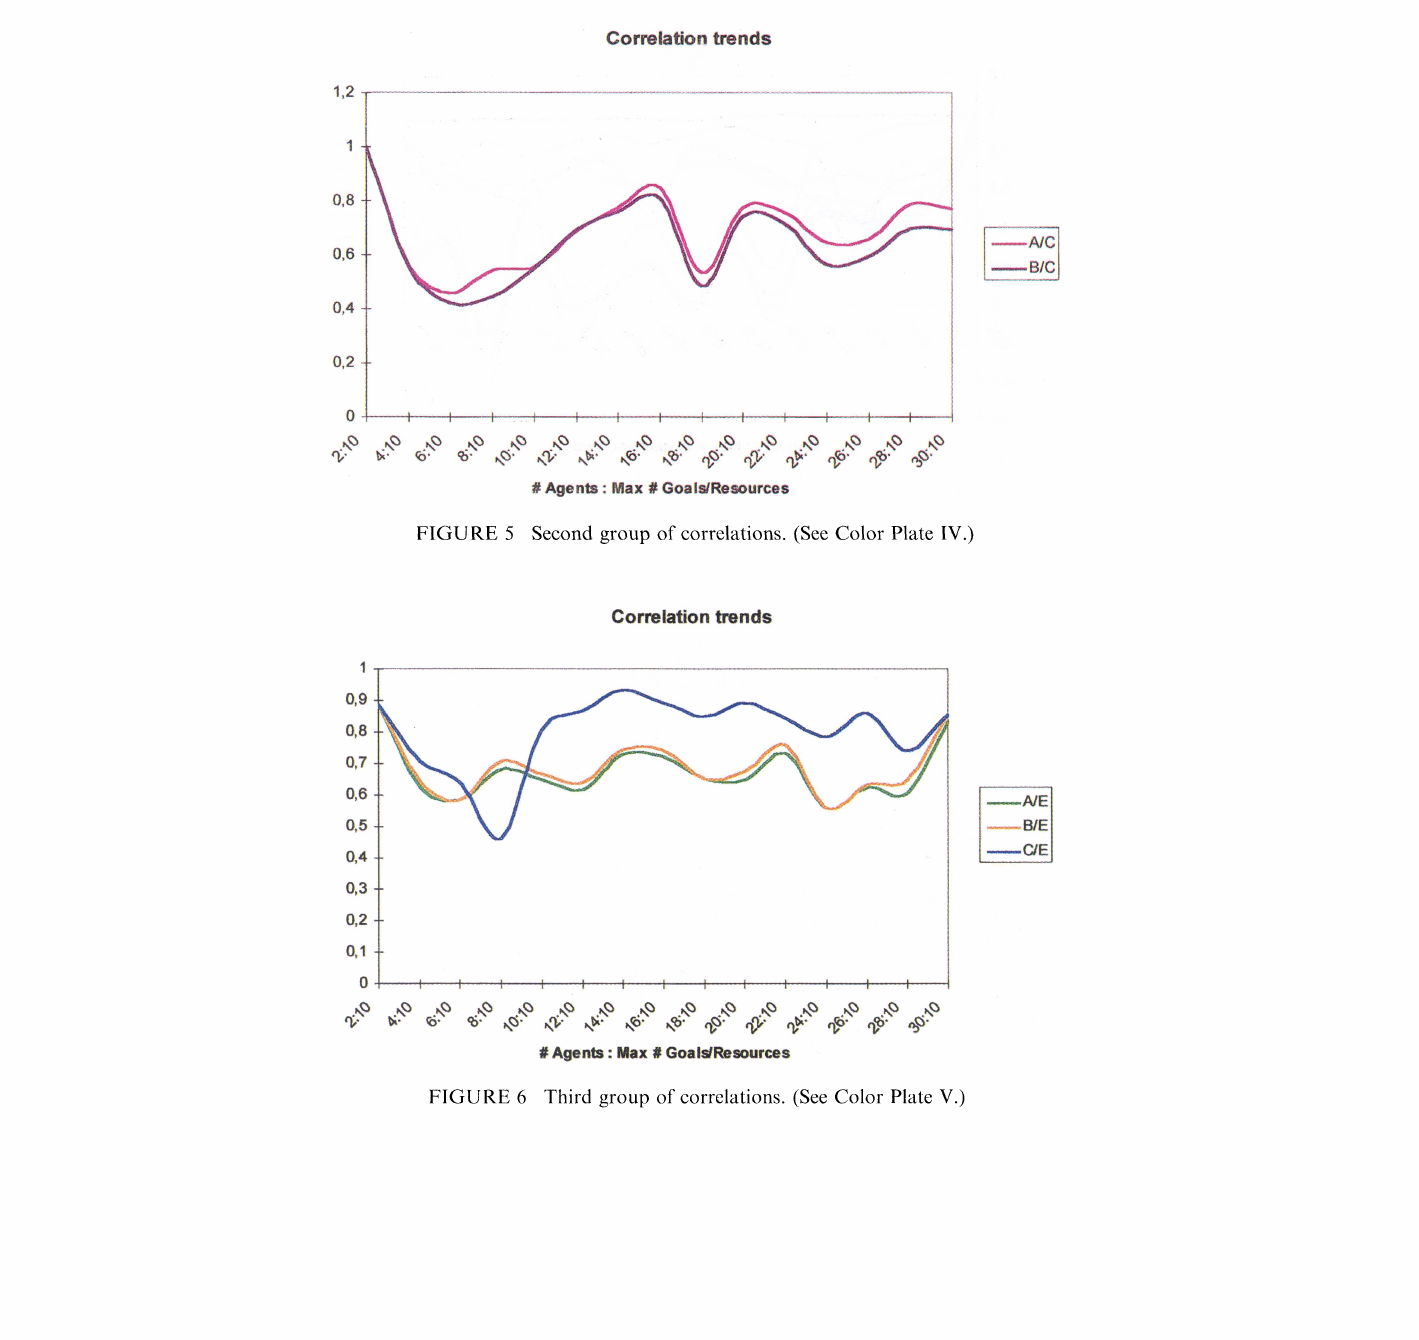
FIGURE 6 Third group of correlations. (See Color Plate